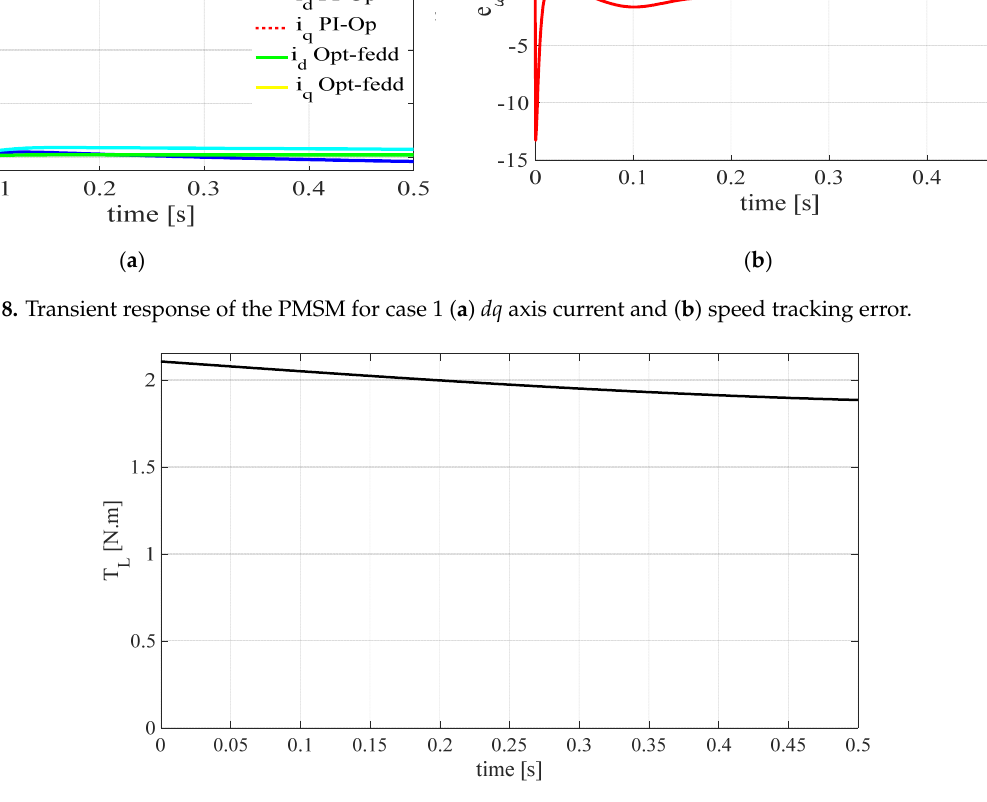
Figure 8. Transient response of the PMSM for case 1 ( a ) dq axis current and ( b ) speed tracking error. Table 3. Speed error performance indices for case 1.